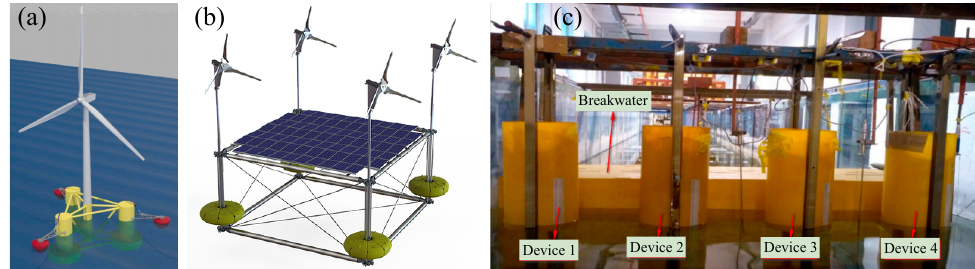
Figure 23. Point absorber wave energy converters are integrated with offshore structures to form a wind-wave platform [295] ( a ), a wind-solar-wave hybrid power system [297] ( b ) and a breakwater- WEC multi-function structure [298] ( c